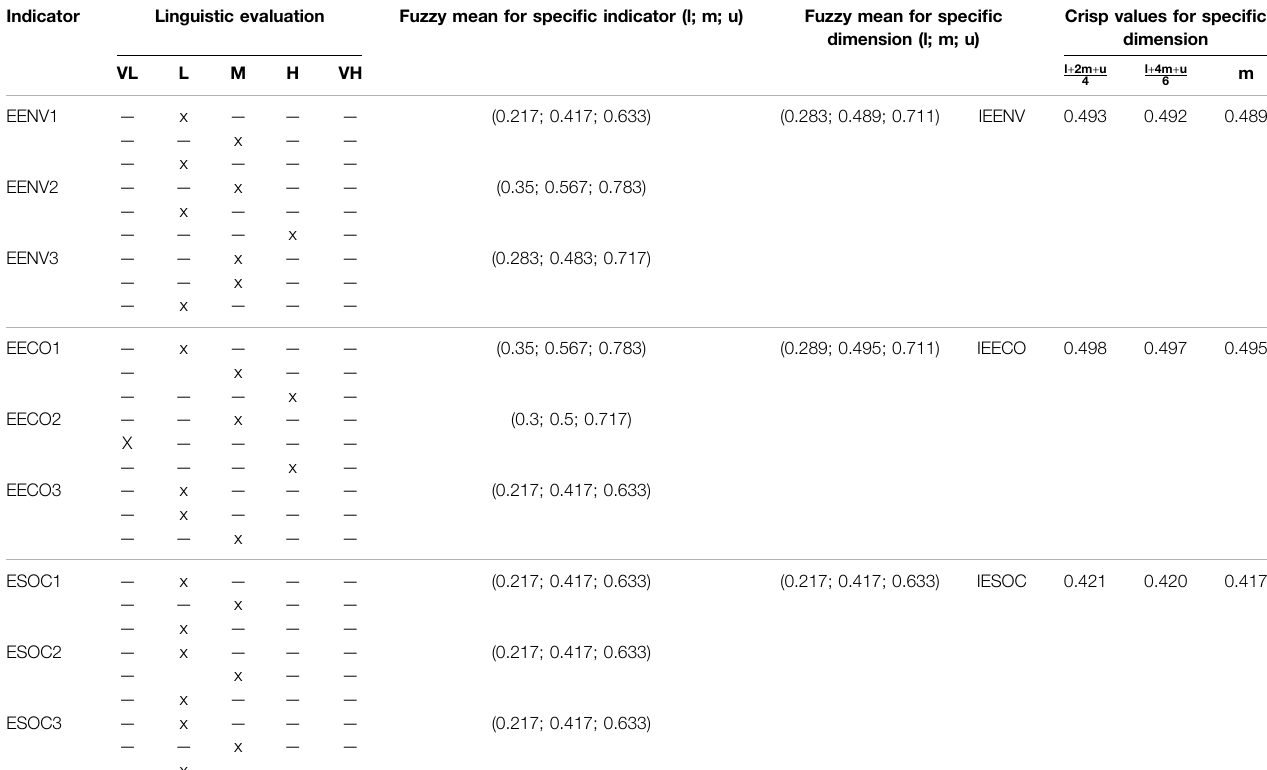
TABLE 4 | Sustainability technology evaluation based on criteria for the considered biodigester using membership functions of variables Indicator Linguistic